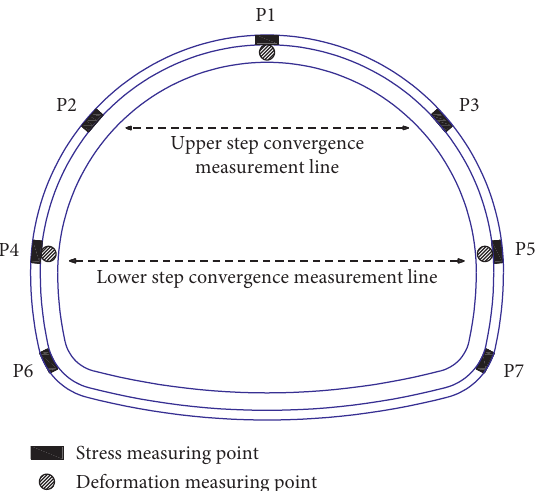
Figure 5: Arrangement of support structure stress and deformation measurement